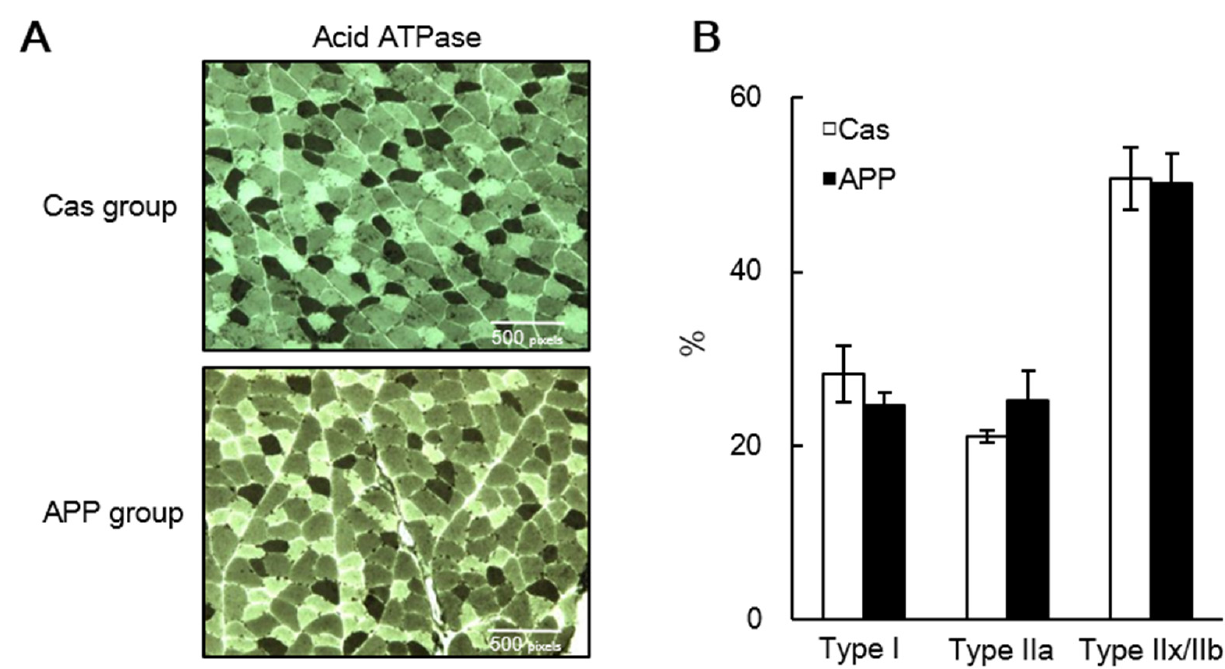
Figure 4. Muscle fiber composition in the gastrocnemius of rats fed a normal-fat casein diet or a normal-fat Alaska pollack protein (APP) diet after 7 days of feeding. Representative transverse sections stained with myosin ATPase preincubated at pH 4.7 ( A ) and percentages of the fiber types ( B ) in the gastrocnemius muscle of normal-fat casein diet group (Cas, n = 3) and normal-fat APP diet group (APP, n = 4) after 7 days of feeding are shown. Dark and light fibers are types I and II, respectively. Data are expressed as the mean ± standard error (SEM). Statistical analysis was performed using Student’s unpaired t -test. Table 4. The effect of APP for 2 days on gene expressions of myosin heavy chains and regulators of muscle mass and metabolism in the gastrocnemius muscles in rats fed a normal-fat diet.